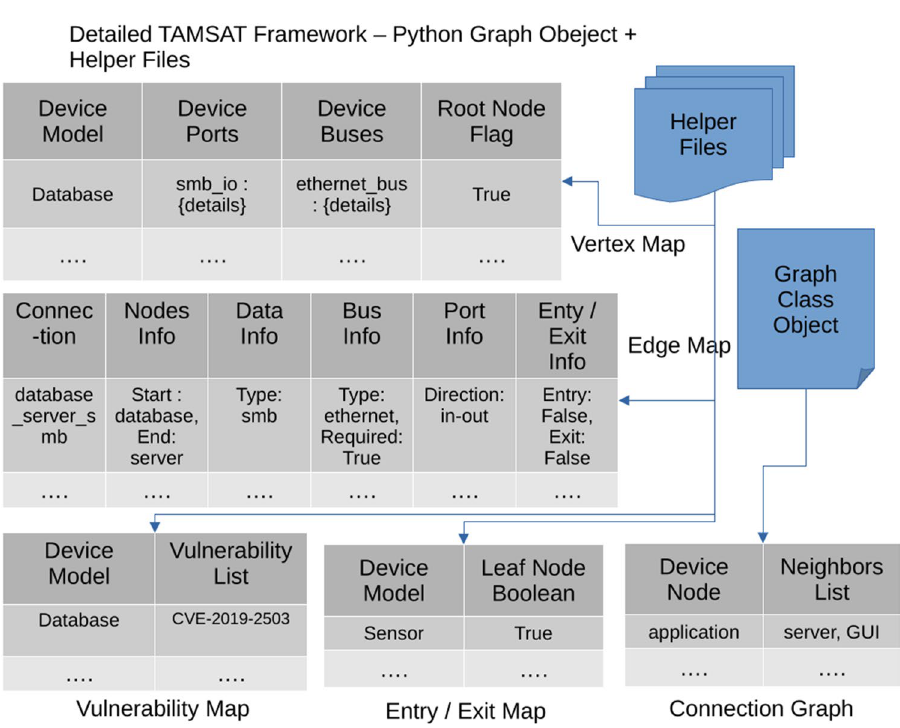
Fig. 7 Illustration of detailed framework for